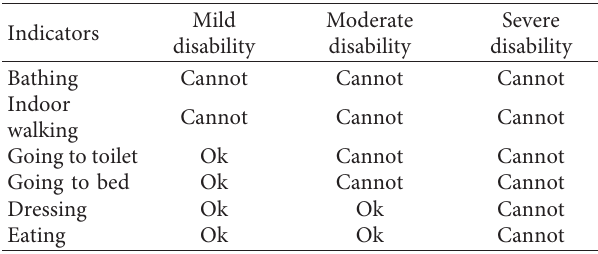
Table 1: Correspondence between indicators and disability.